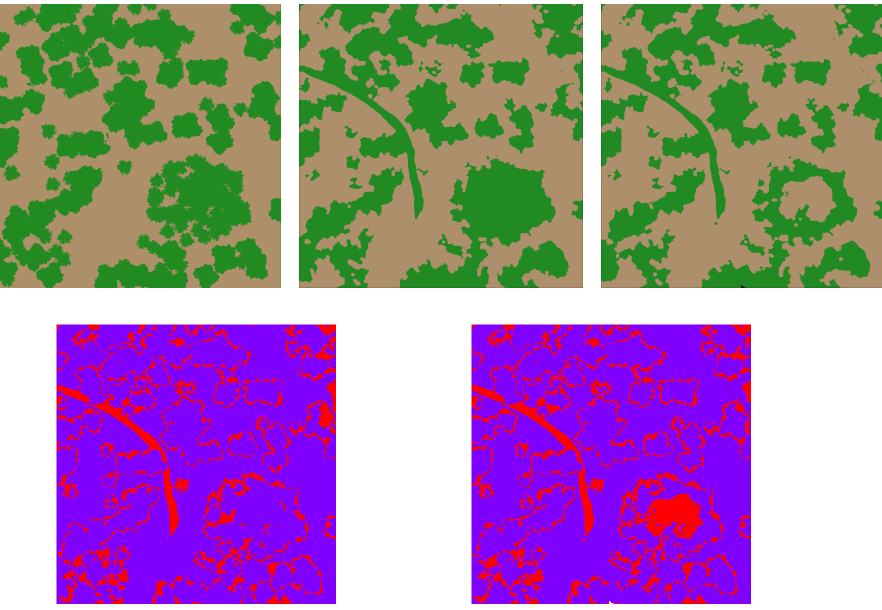
Figure 16. ( Top left ): Expected segmentation from the real mesh. ( Top middle ): segmentation using the ground estimation correction. ( Top right ): segmentation with the default ground estimation. ( Bottom ): difference between the expected segmentation and, at ( left ), the one with the ground estimation correction and at ( right ), with the default